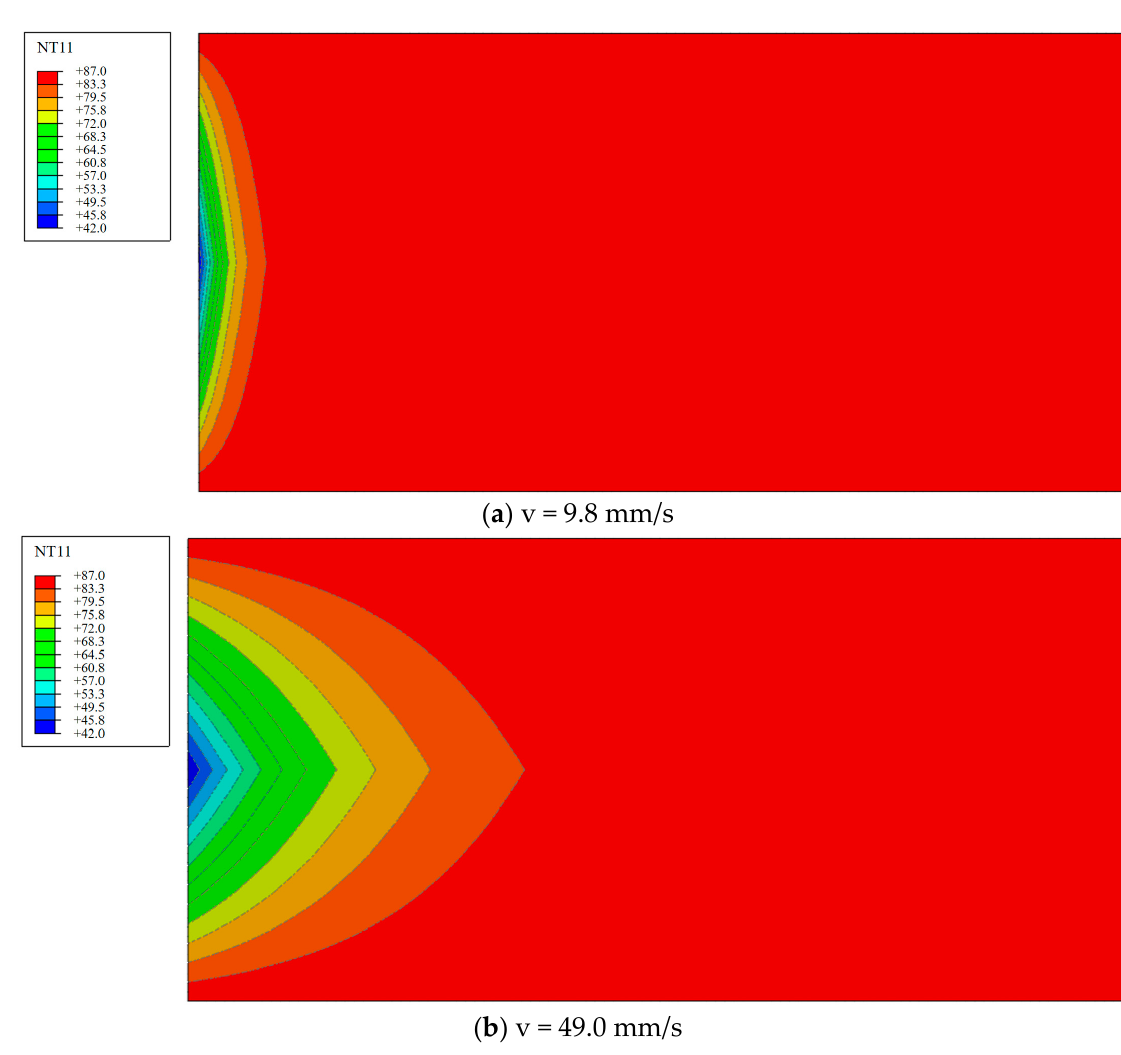
Figure 4. Diagram of temperature field distribution under different velocities of flow (unit: °C).